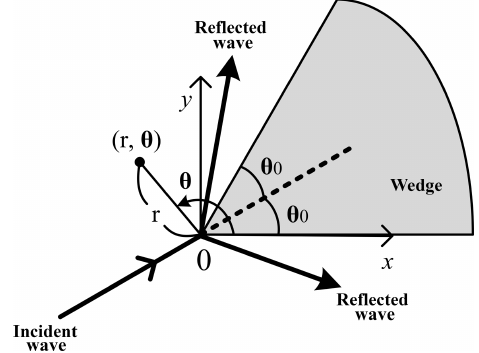
Figure 1. Definition sketch of wave field around a vertical